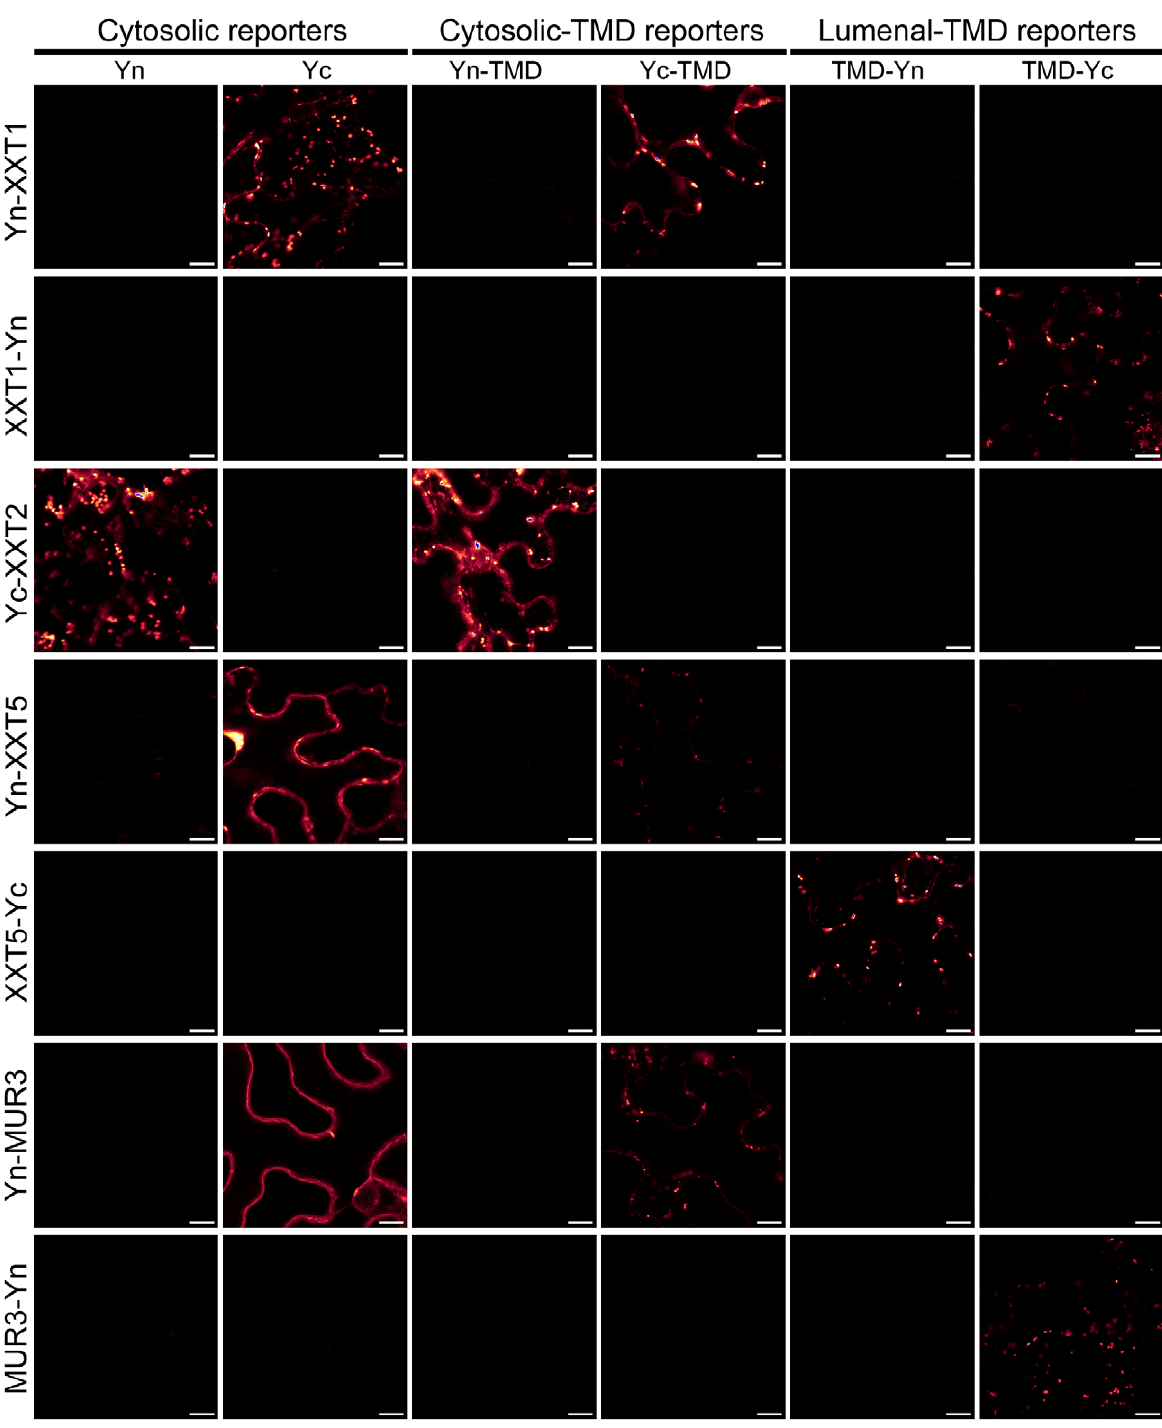
PLoS ONE | www.plosone.org 7 February 2012 | Volume 7 | Issue 2 |